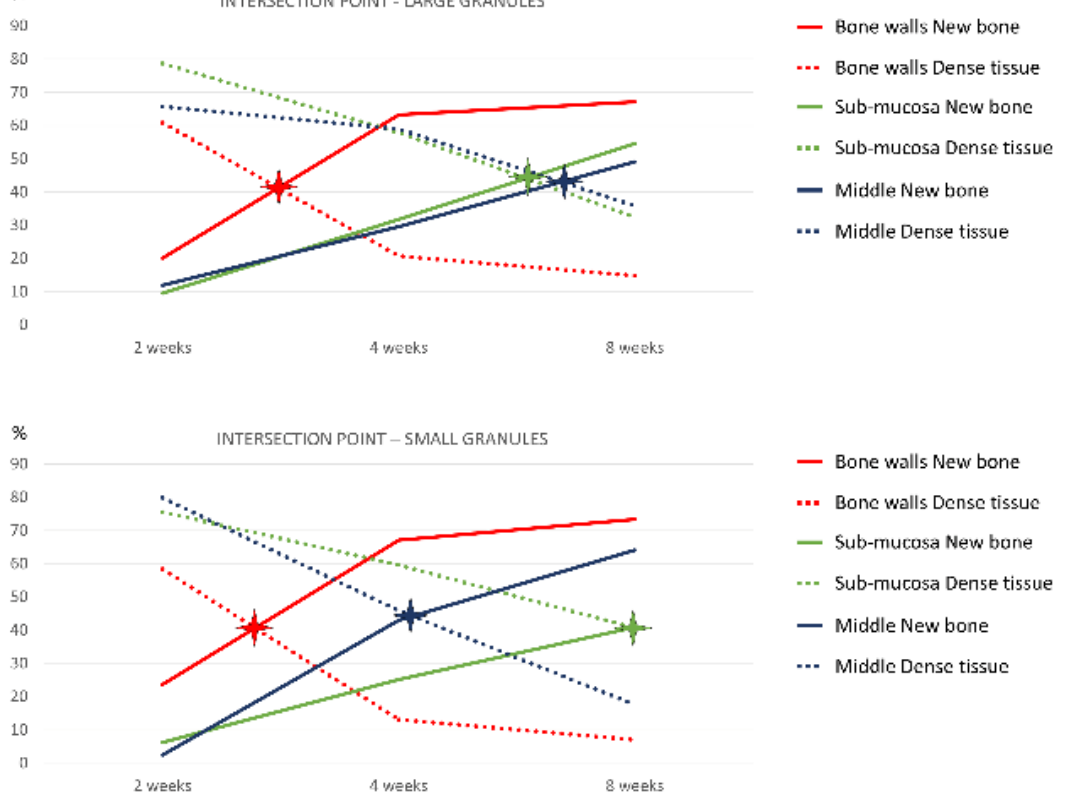
Figure 8. Graphs representing the percentages of BGC and dense tissue in contact with the graft surface in the various regions and periods evaluated. Stars indicate the intersection point between new bone and dense tissue.